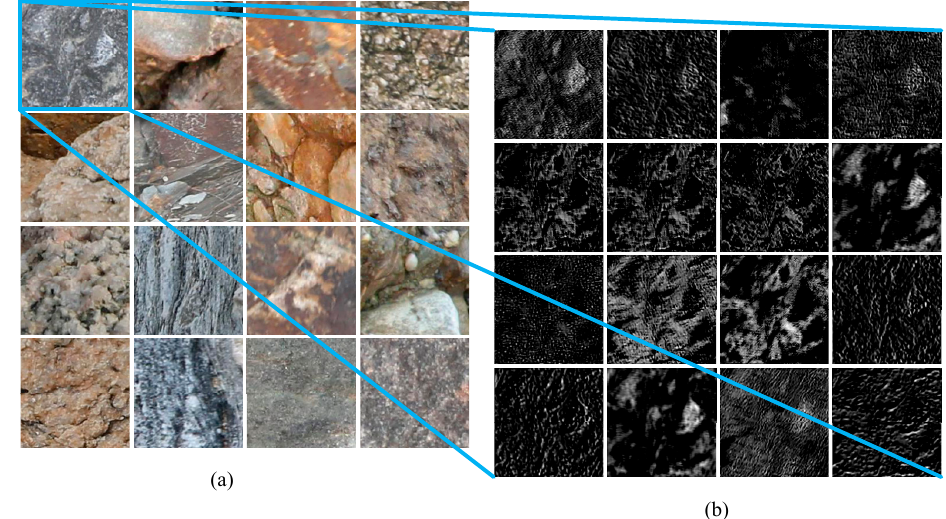
Figure 3. Learned rock features after convolution by the RTCNNs model. ( a ) Input patched field rock sample images. ( b ) Outputted feature maps partly after the first convolution of the input image, from the upper left corner in (a).